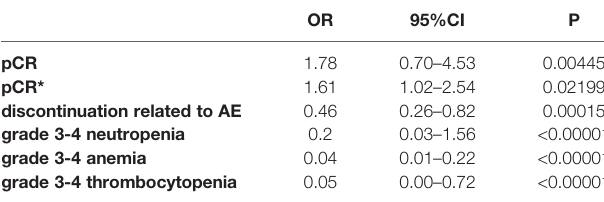
TABLE 2 | Results of indirect